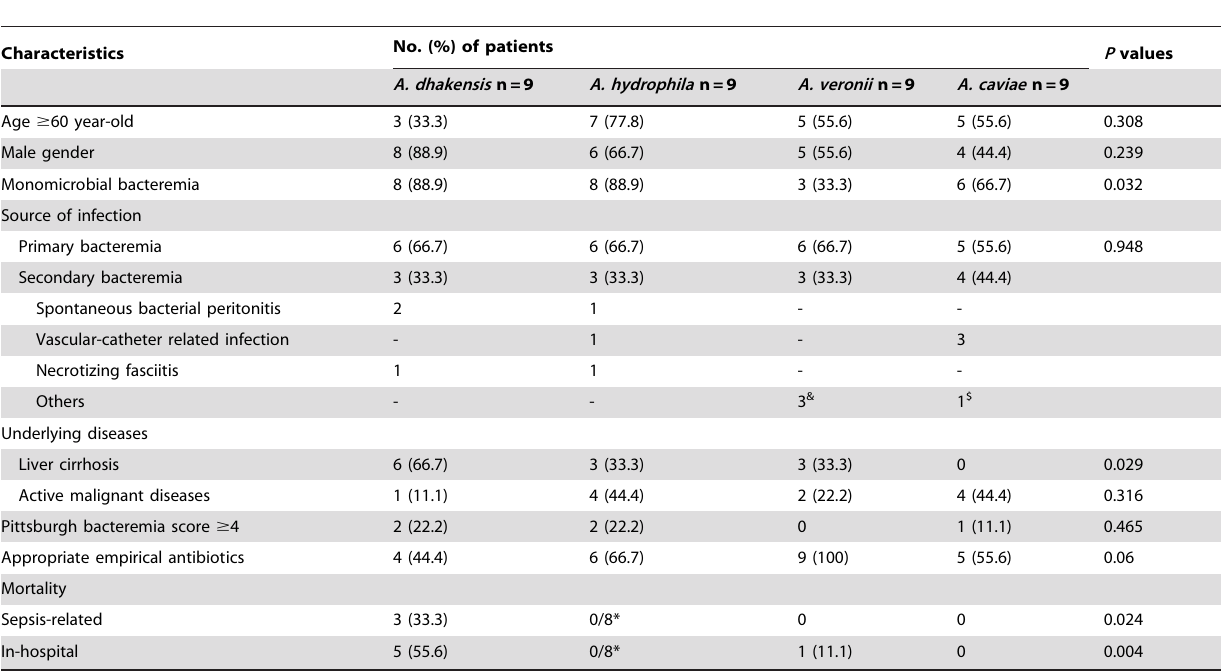
Table 1. Clinical features of patients with septicemia caused by different Aeromonas species.